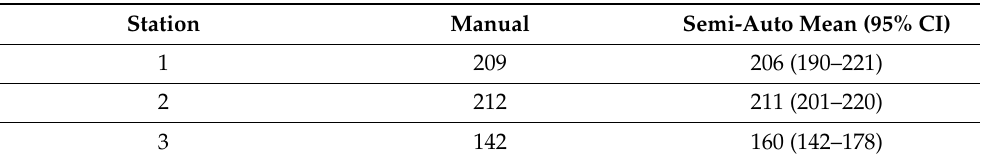
Figure 3. Mean densities of Aurelia sp. estimated from the net sampling (dark grey bar) and from the drone images (medium and light gray bars; respectively, the manual and semiautomated methods). The mean and standard deviation were computed from the three sampling stations for each method. Table 1. Numbers of Aurelia sp. counted on drone pictures for the three sampling stations, including the manual counts with ImageJ (“Manual”) and the mean (95% CI, n = 100 iterations) from the counts with the RStudio detection program